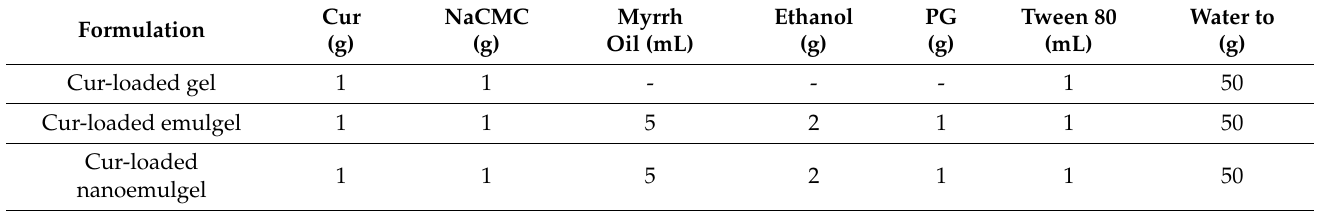
Table 1. Composition of various Cur-loaded topical preparations.